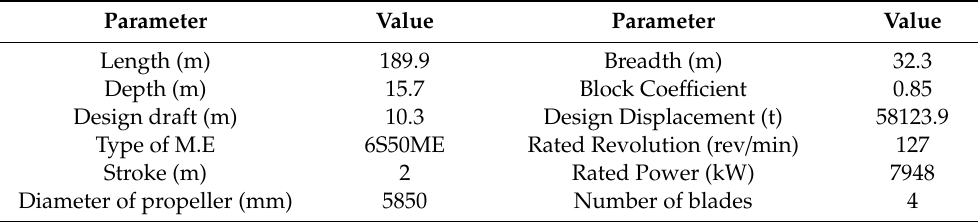
Table 2. Parameters of the YUMING vessel.